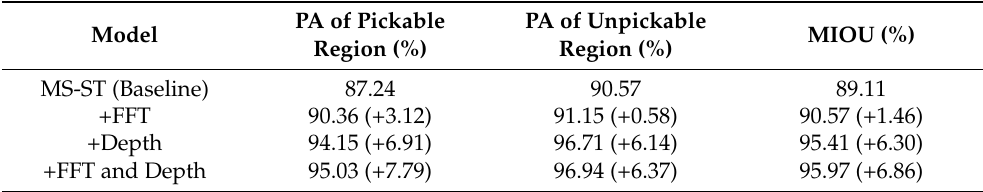
Table 4. The PA and MIOU on the parcel dataset with different supervision signals.